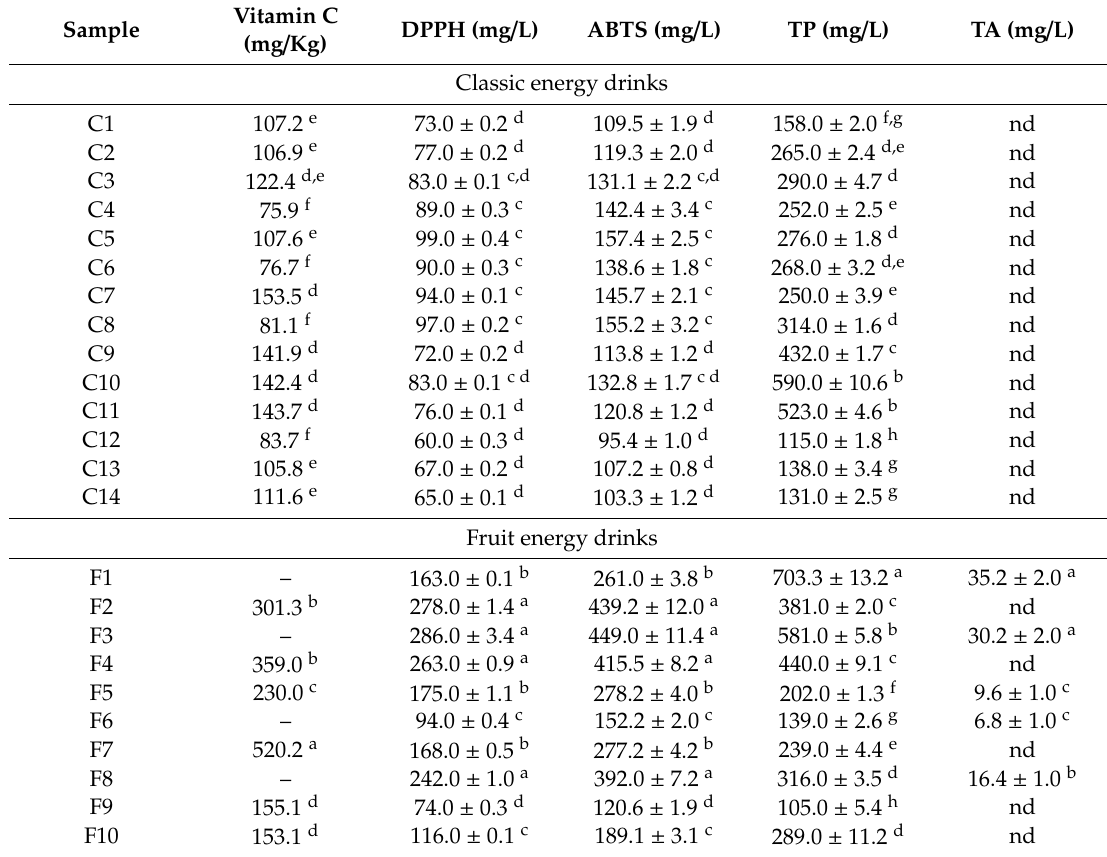
Table 2. Antioxidant properties of various energy